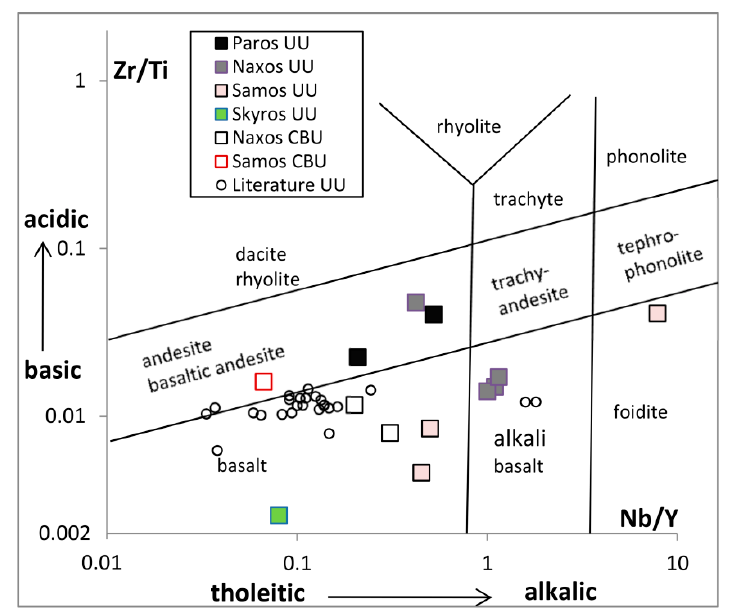
Figure 5. Classification of Aegean ophiolitic metabasites using the immobile element-based TAS proxy diagram (modified after [53,54]). Literature data for Upper Unit metabasites are plotted for comparison (see text).